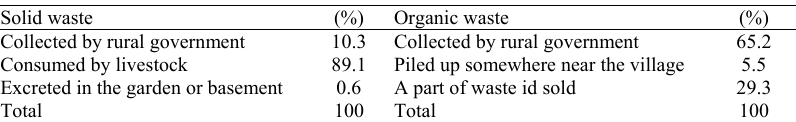
Table 3: DW collection and disposal of organic and solid waste